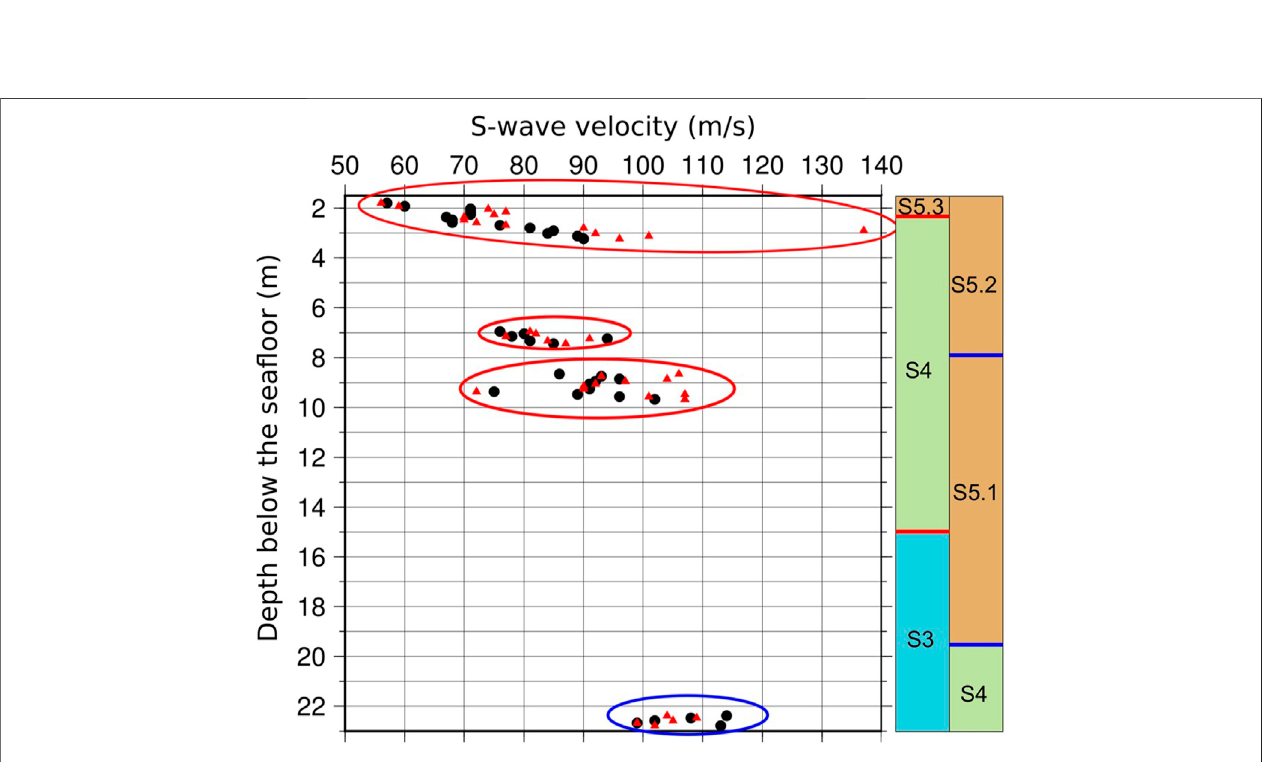
FIGURE12| LaboratoryS-wavevelocitymeasurements.Samplessurroundedbyredellipsesareacquired fromthepockmarkandbluesurroundedonesarefrom the reference site. Black circles are the velocities derived in time domain. Red triangles are those derived in frequency domain. Two columns represent the stratigraphy within the pockmark (left) and at the reference site